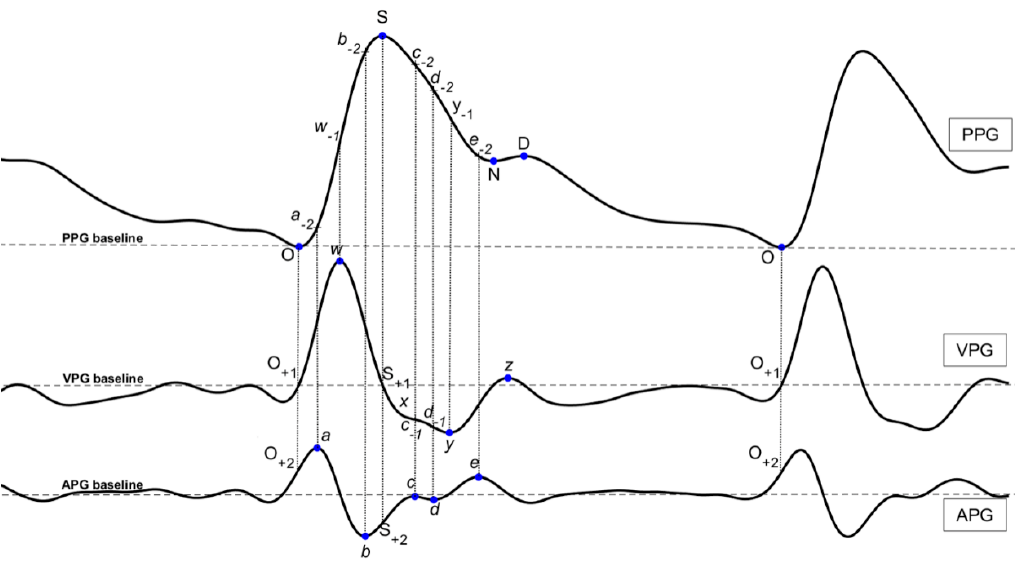
Figure 2. The definition of the characteristics in PPG and its derivatives.